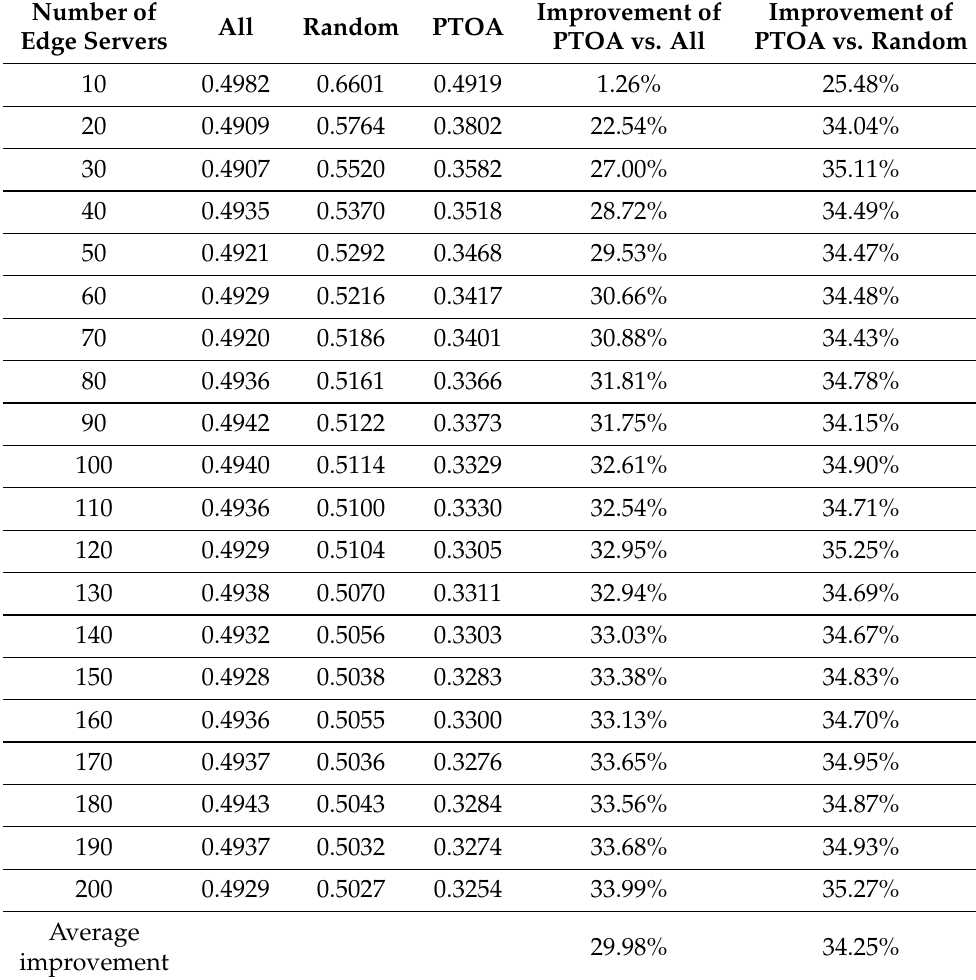
Table 7. Comparison of the average completion time of PTOA with the methods All and Random with different numbers of edge